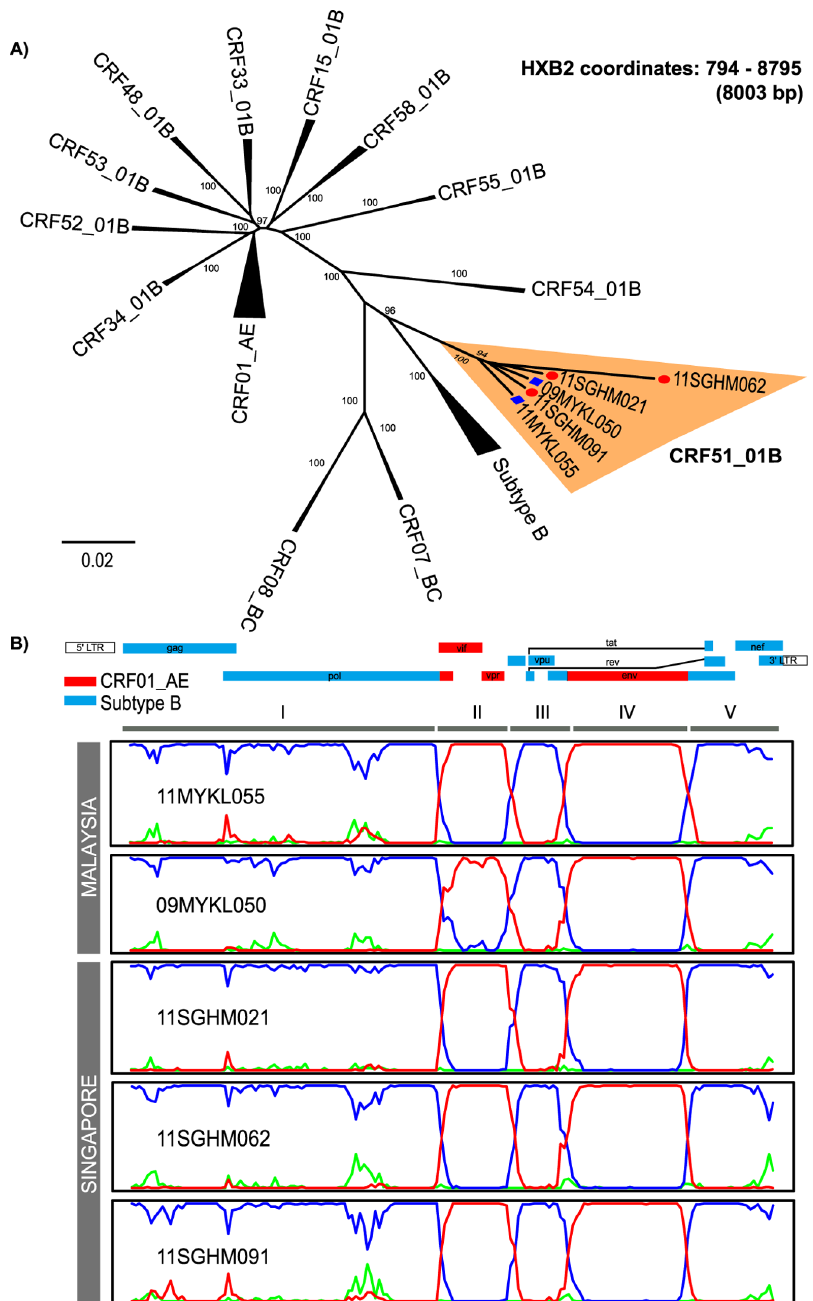
Figure 1. Phylogenetic and recombination analysis of HIV-1 CRF51_01B near full length genomes. A . Neighbour-joining analysis of the near full length sequences of 11MYKL055 and 09MYKL050 (HXB2 coordinates: 794–8795, 8003 bp) isolated from Malaysia against reference sequences of different subtypes/CRFs. CRF51_01B isolates from Singapore and Malaysia are indicated by red circles and blue squares, respectively. B . Bootscan analysis of all available near-full length genomes of CRF51_01B from Malaysia (11MYKL055 and 09MYKL050) and Singapore (11SGHM021, 11SGHM062 and 11SGHM091) using 83USSF2 (subtype B) of western origin, 90THCM235 (CRF01_AE) as putative parental strains, and subtype C (95IN21068) as an outlier strain. Subtype B, CRF01_AE and subtype C strains are represented by blue, red and green lines,